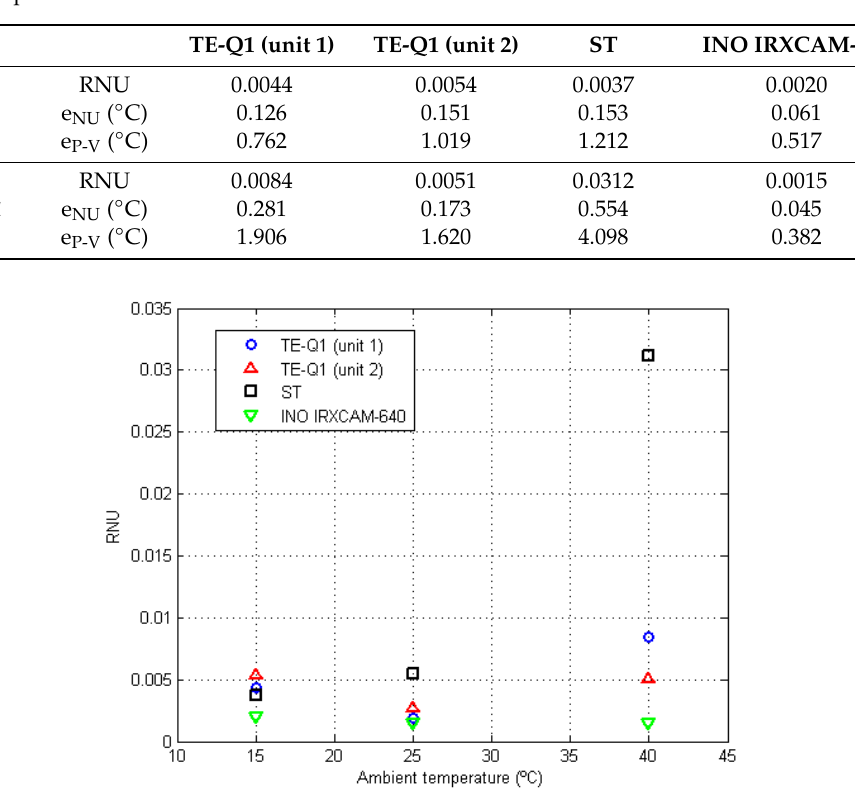
Table 7. RNU, e NU , and e P-V values for a blackbody temperature T obj = 32 ◦ C and di ff erent room temperatures.